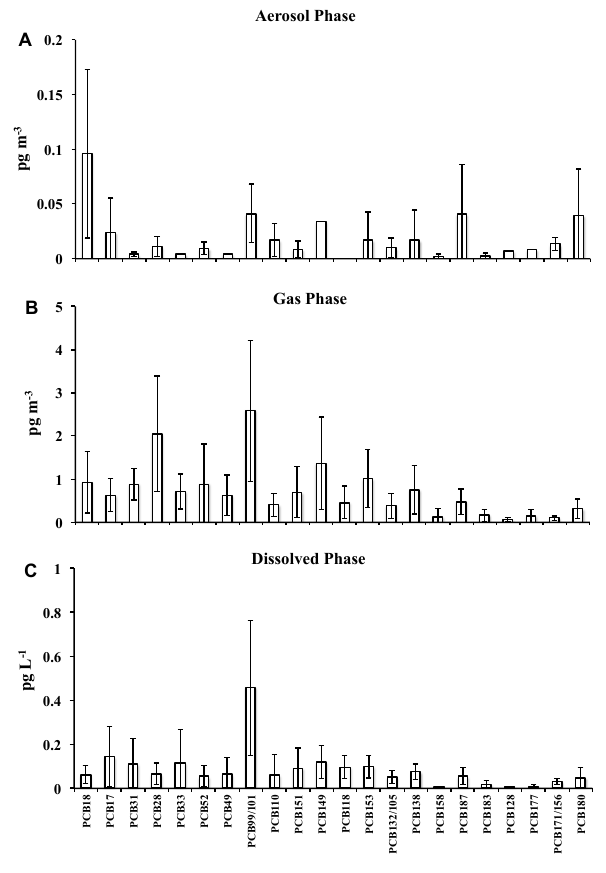
Fig. 1. Congener specific occurrence of PCBs. Average profiles of PCB congeners in the aerosol ( A , pgm − 3 ) , gas ( B , pgm − 3 ) and dissolved phase ( C , pgL − 1 ) in the Southern Ocean. Dissolved phase concentrations are taken from Galbán-Malagón et al.